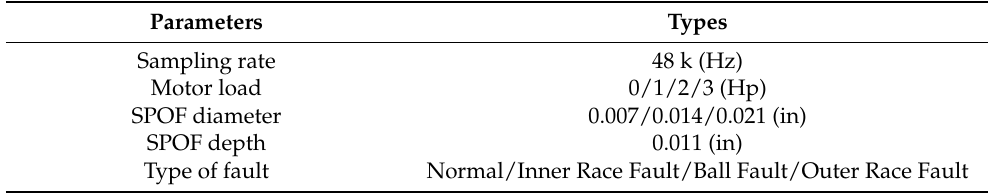
Figure 1. Ball bearing experiment platform. Table 1. Data Information.